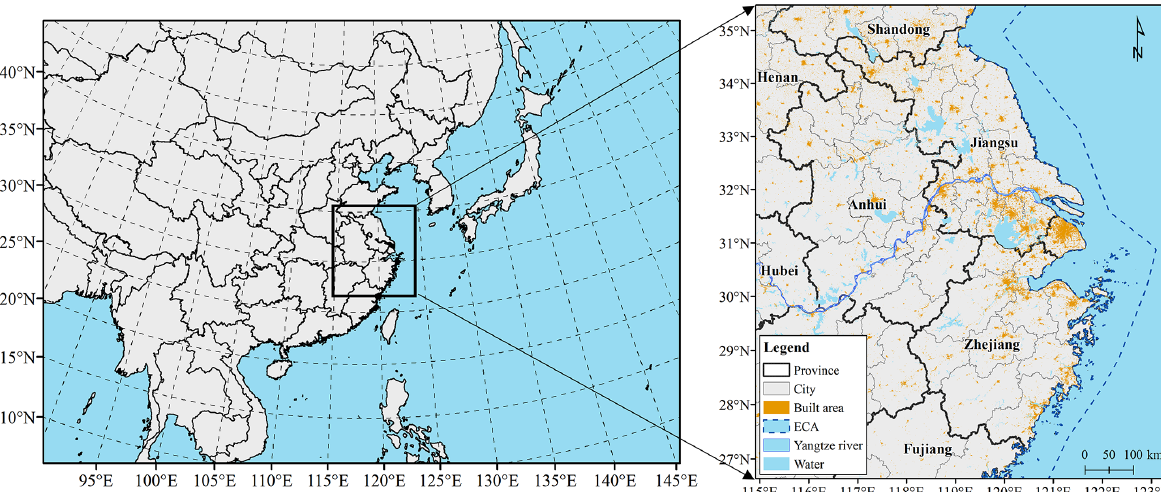
Figure 1. The domain of the YRD region in this study. Coastal waters within the dashed line on the expanded image represent ship emission control